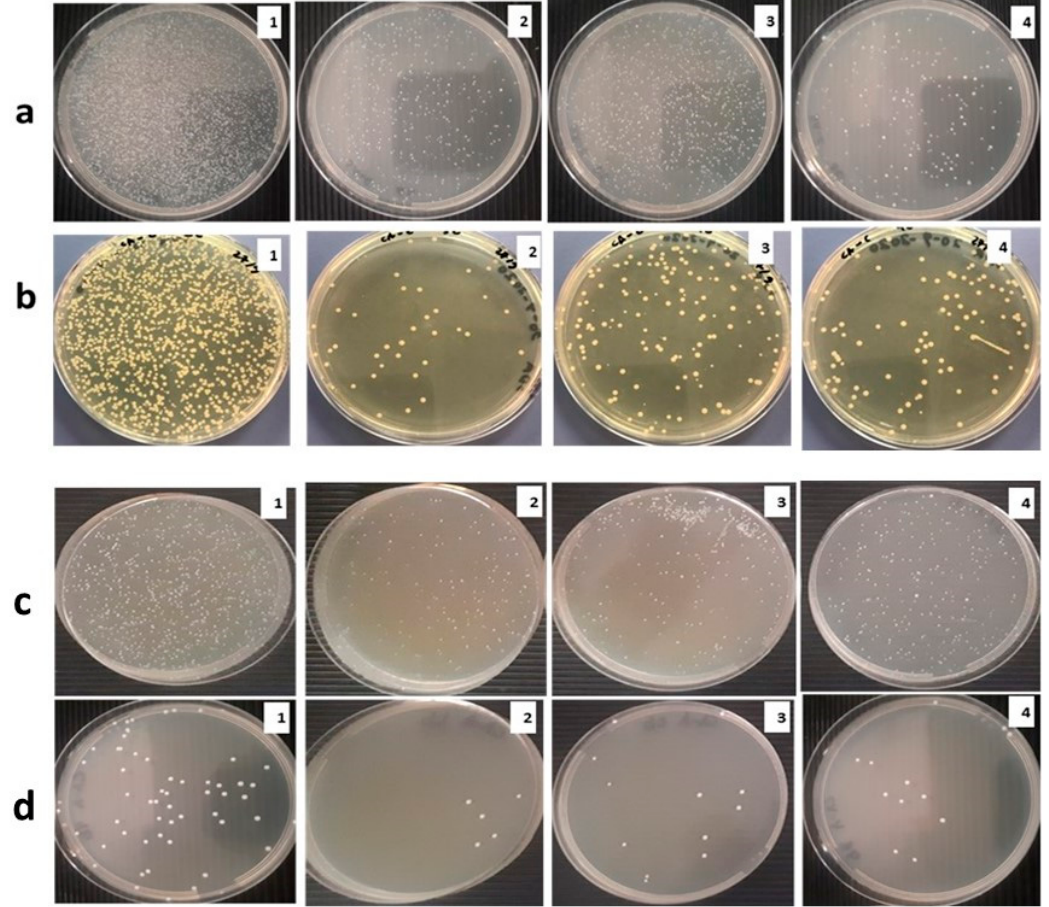
Figure 7. Macroscopic observations of adherent cell count of ( a ) S. aureus and ( b ) C. albicans after incubation for 48 h and ( c ) S. aureus and ( d ) C. albicans after incubation for 168 h. (1: SS; 2: EST; 3: nHA/EG; 4: EG).